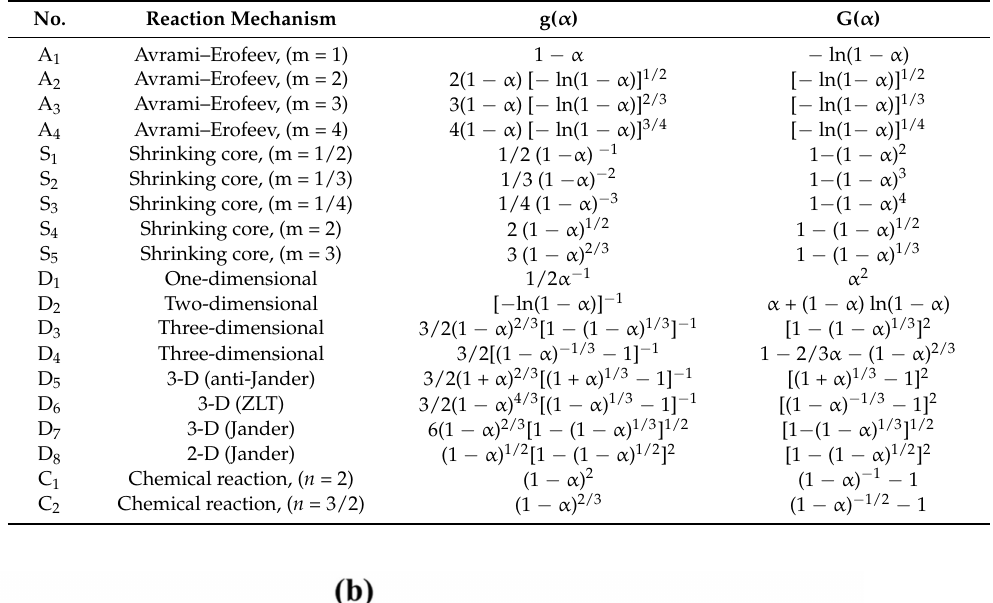
Table 3. Common mechanism functions in gas–solid reactions [23–25] (Adapted with permission from ref. [23–25], 2012 and 2013 Peng, L and 2015 Sun, Y).